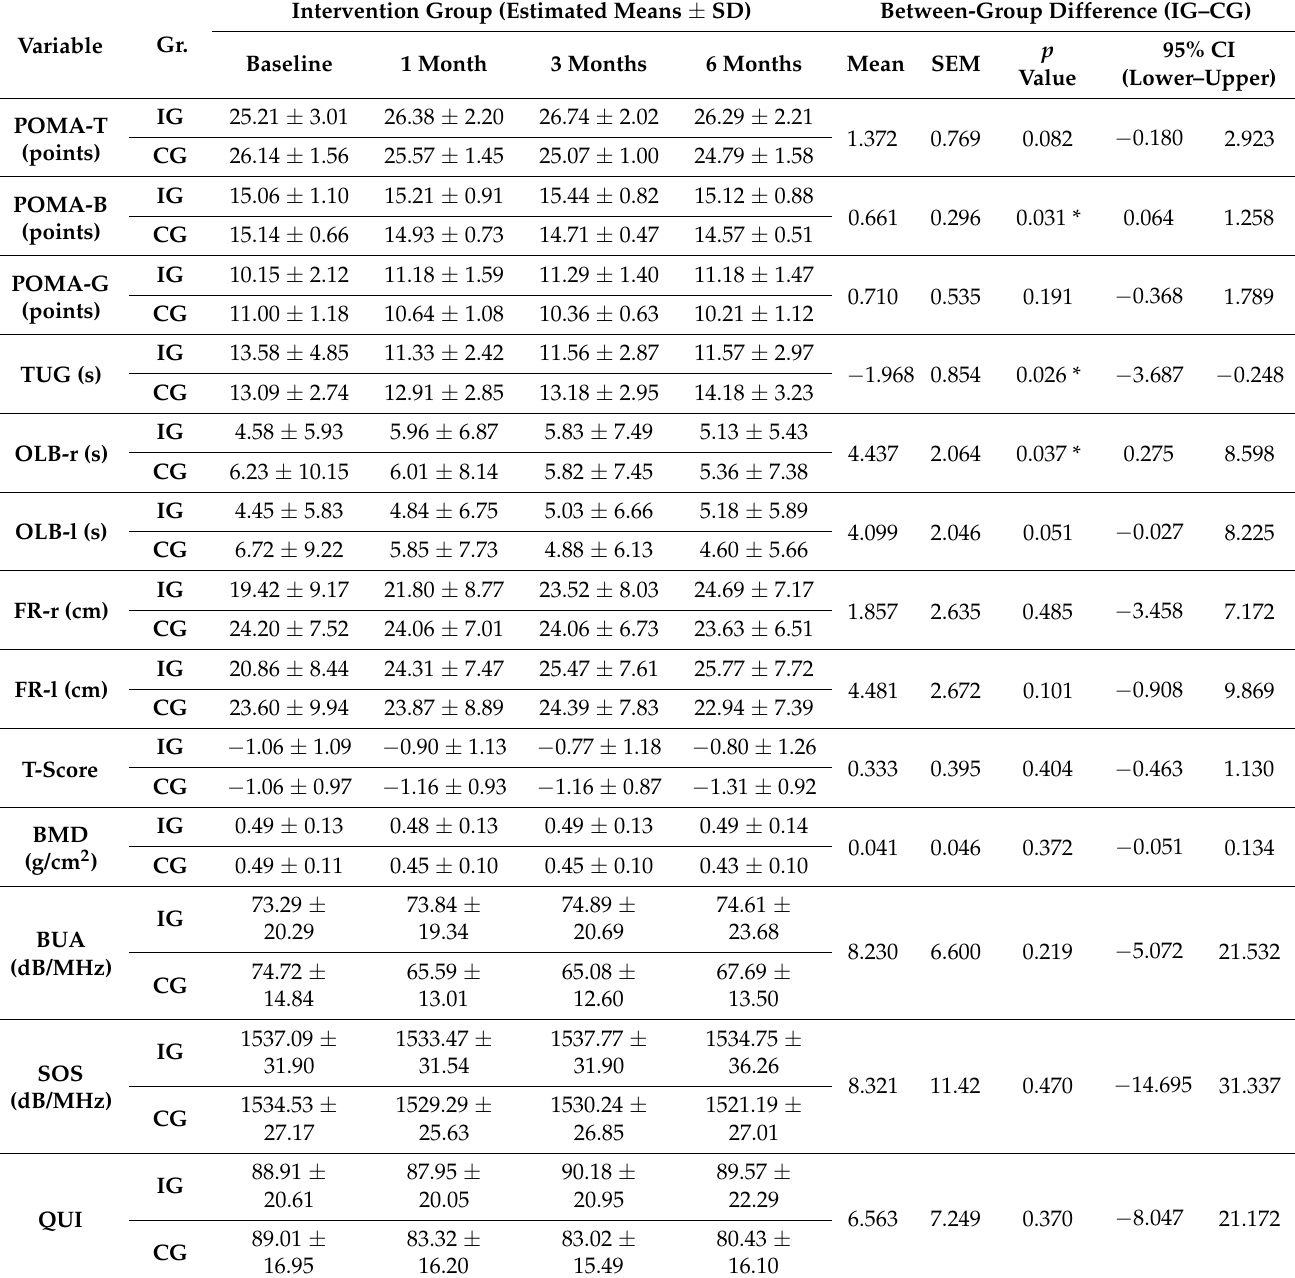
Table 2. Changes in primary and secondary outcomes from baseline to 6 months and between-group differences with age as a covariate when